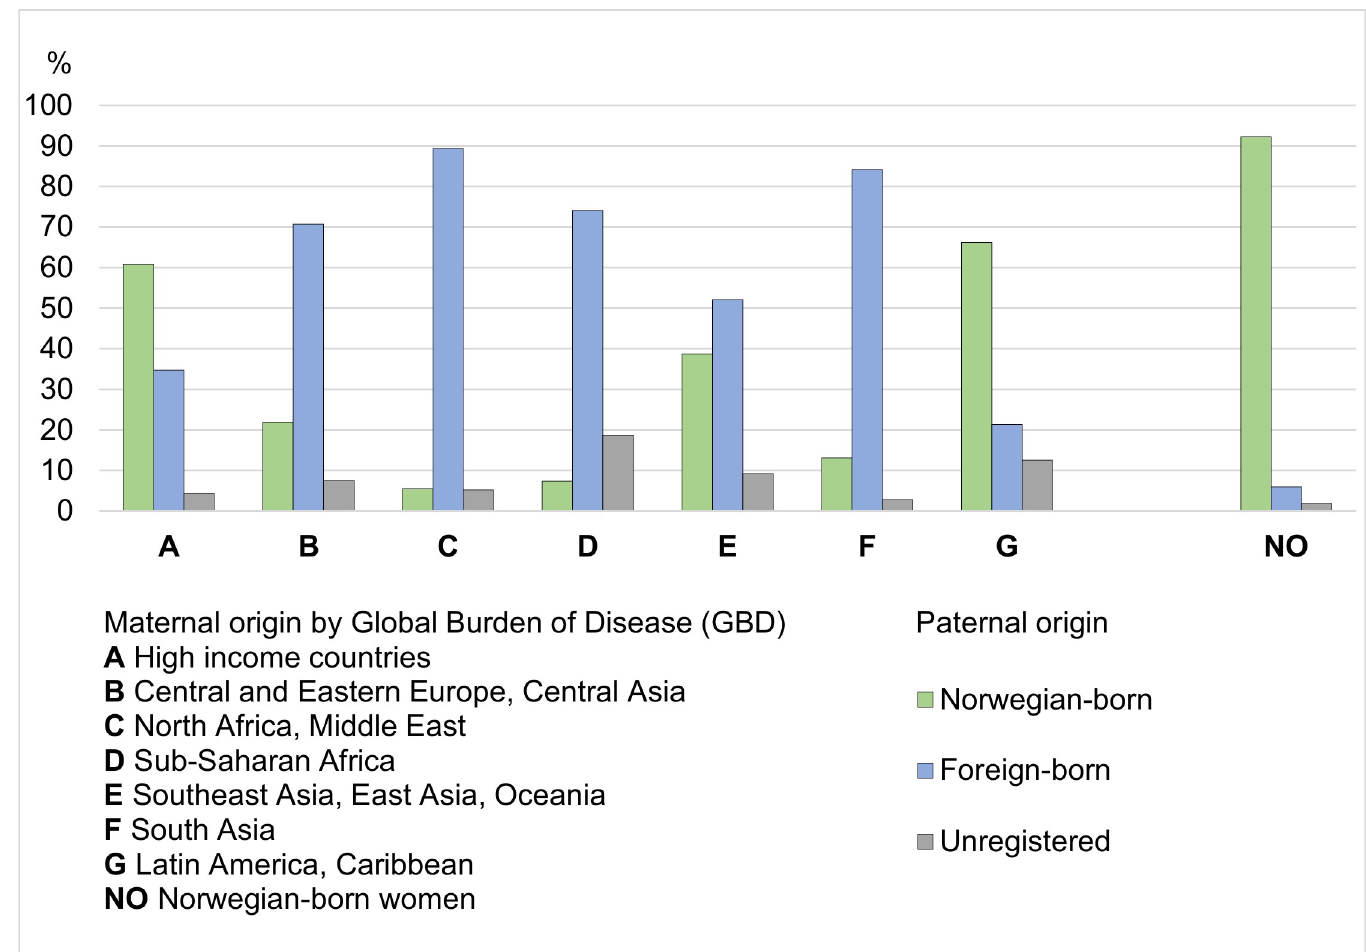
Fig 2. Proportion of births to migrant and Norwegian-born women giving birth in Norway (1990–2016) by maternal region of birth (GBD categories; Norwegian- born women in a separate category) and paternal origin (Norwegian-born, foreign-born, and unregistered). GBD, Global Burden of Disease.